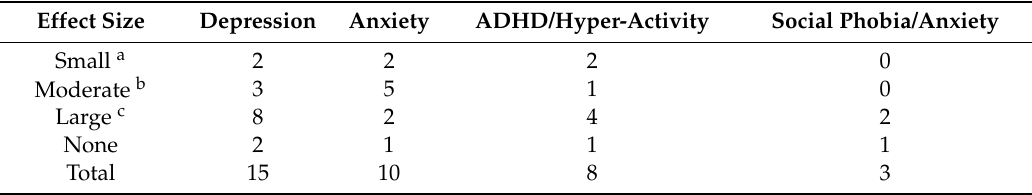
Table 2. Number of observed associations identified between IGD and psychopathology stratified by effect size for the four main outcomes. Effect Size Depression Anxiety